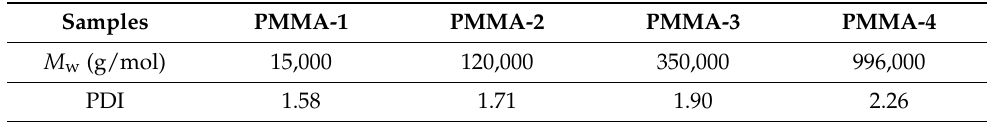
Table 1. PMMA with different molecular weights used in this